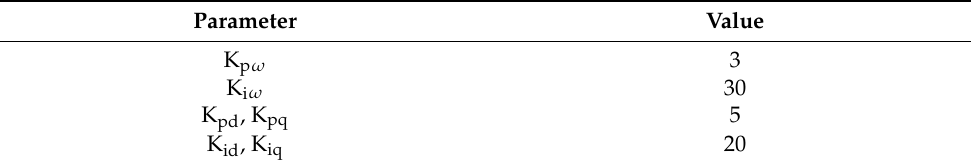
Table 7. Controller parameter.